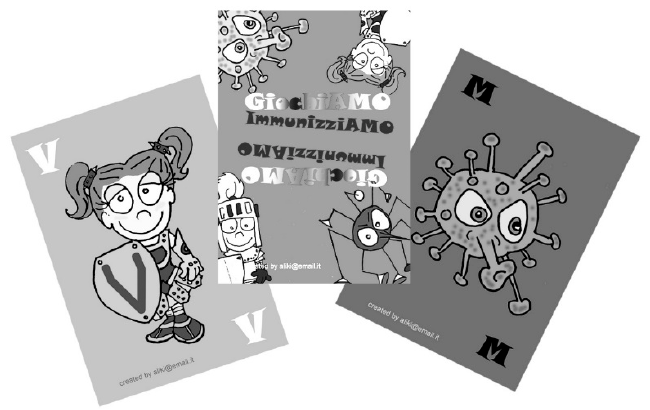
Figure 1. Examples of cards used in the Immunizziamo project.